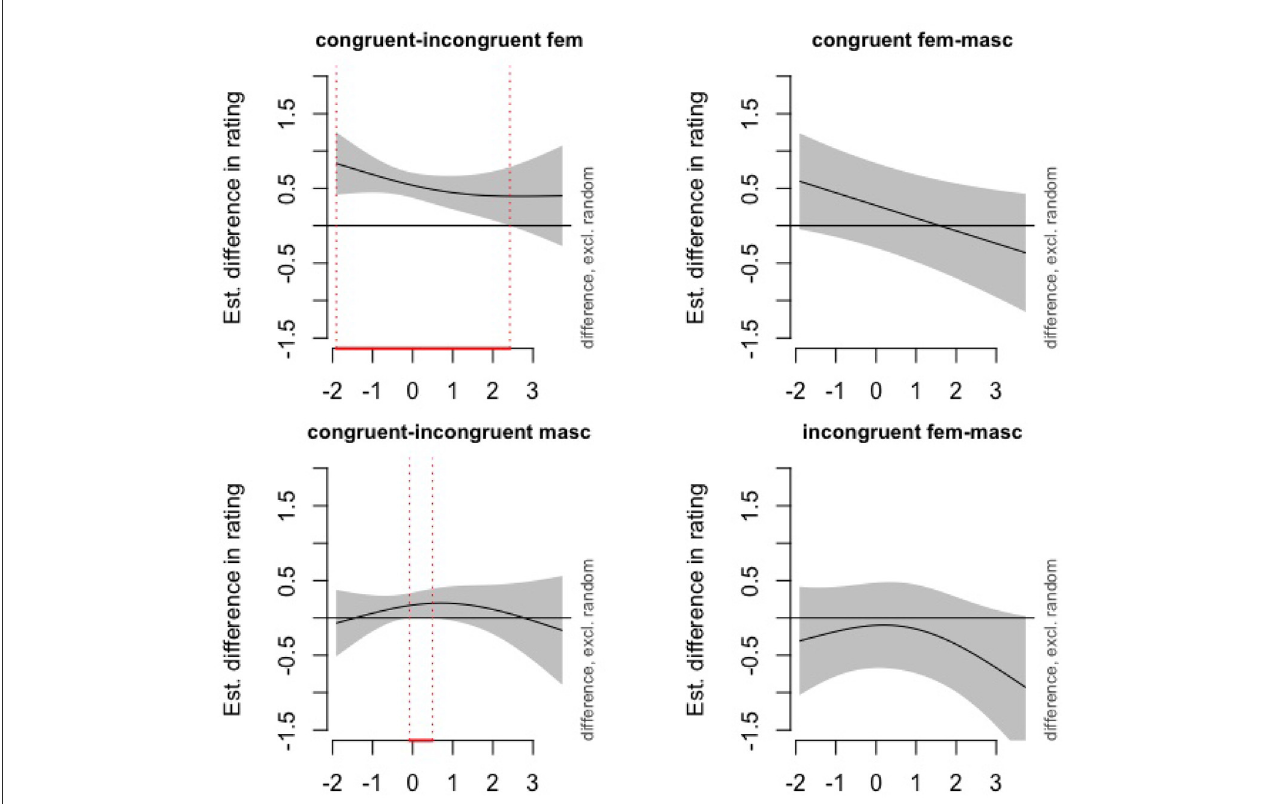
FIGURE3 Political Ideology: Difference plots depicting the interaction between political ideology and stereotype congruence. More negative/positive values on the x-axis indicate lower/higher conservatism. (Upper left) Congruent minus incongruent female stereotyped role name; (Upper right) congruent female minus congruent male stereotyped role name; (Lower left) congruent minus incongruent male stereotyped role name; (Lower right) congruent female minus incongruent female stereotyped role name. Vertical, red, dotted lines indicate the area of significant